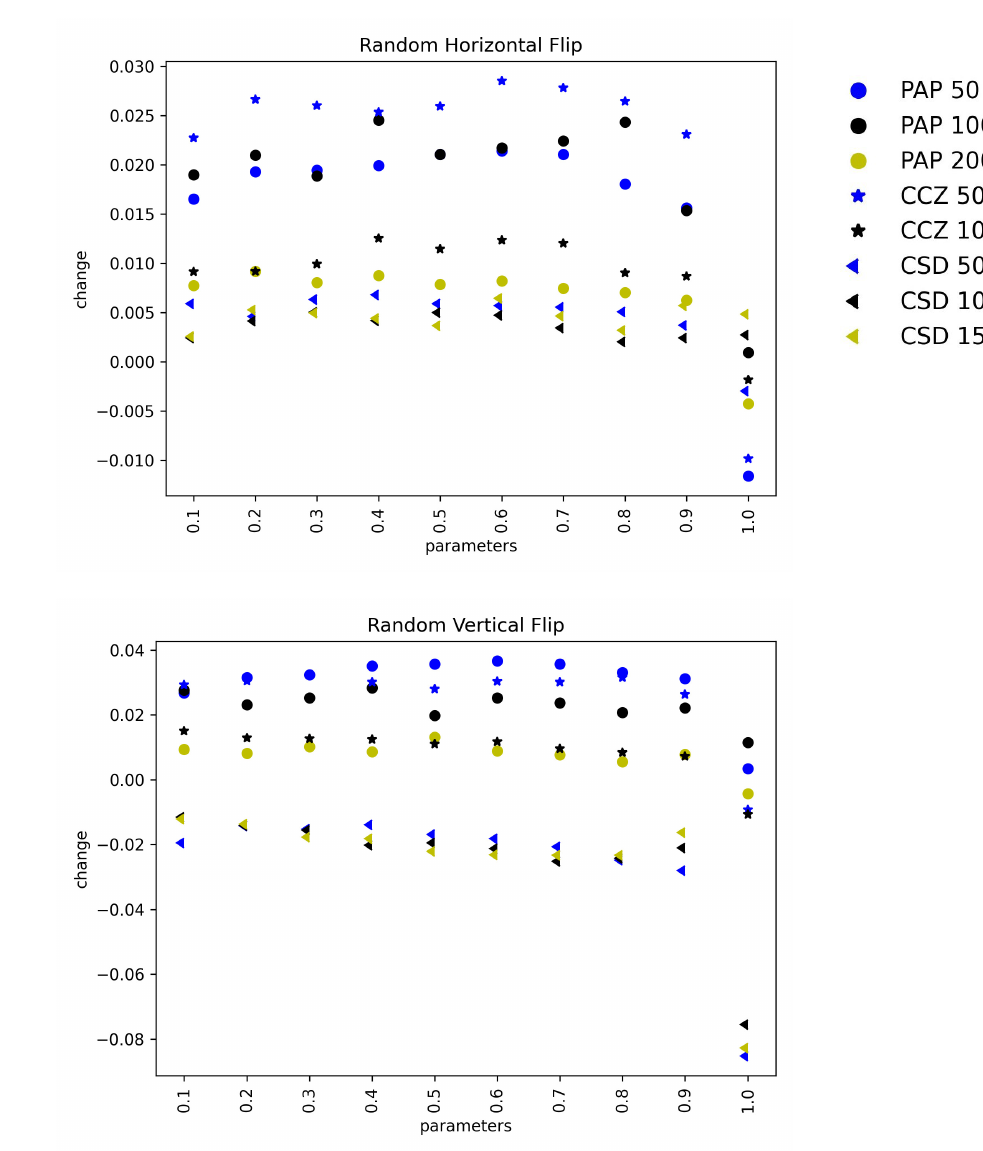
Figure A1. Impacts comparison of Random Horizontal Flip and Random Vertical Flip. The figure reveals the impacts of the different parameters of Random Horizontal Flip and Random Vertical Flip on Γ PAP , Γ CCZ and Γ CSD classification mAA